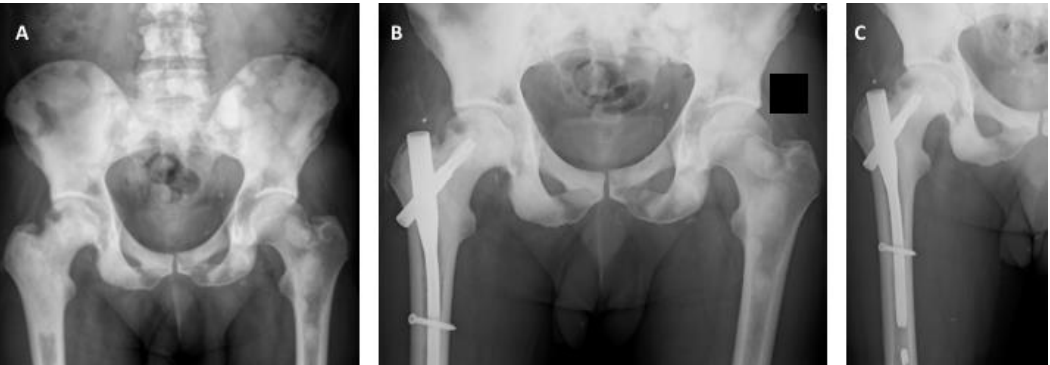
Figure 4. ( A ) Anteroposterior pelvic radiograph showing countless prostate carcinoma metastases around the lower spine, pelvis and proximal femur. Extensive invasion of the pertrochanteric area of the right proximal femur associated with mechanical pain can also be observed. ( B ) Postoperative anteroposterior radiograph of the pelvis after surgical stabilization of the right proximal femur me- tastasis using a cephalomedullary nail. ( C ) Anteroposterior radiograph of the right hip after surgical stabilization of prostate cancer metastasis in the proximal femur. A broken drill is visible in the medullary canal.